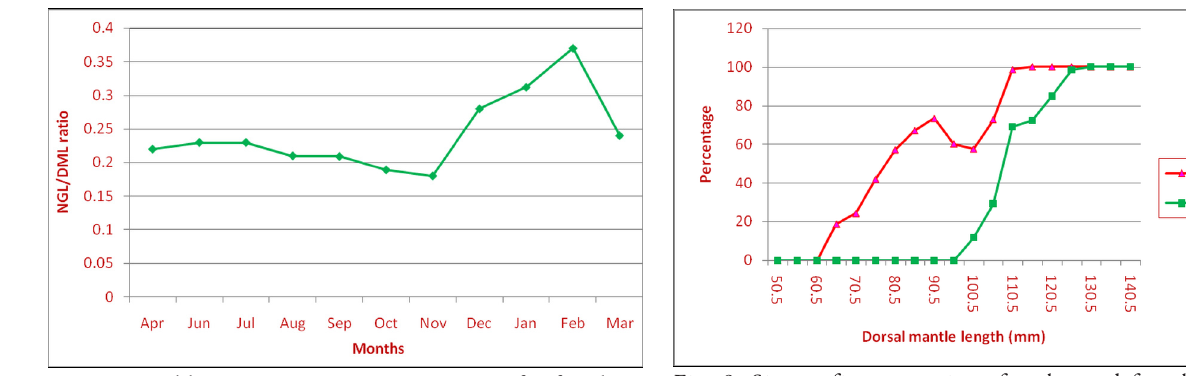
Fig. 7. Monthly variation in NGL/DML ratio for female S. lessoniana